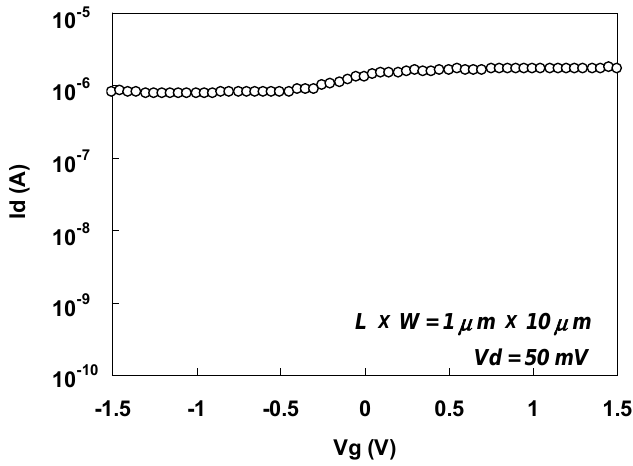
Figure 43. Id-Vg characteristics for an n-MOSFET immediately after implantation of sulfur.